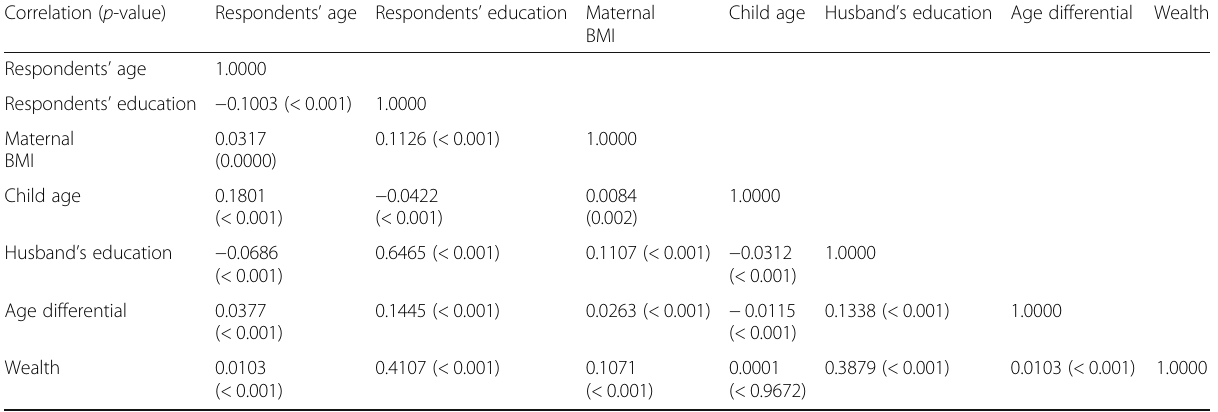
Table 4 Correlation between Covariates Correlation ( p